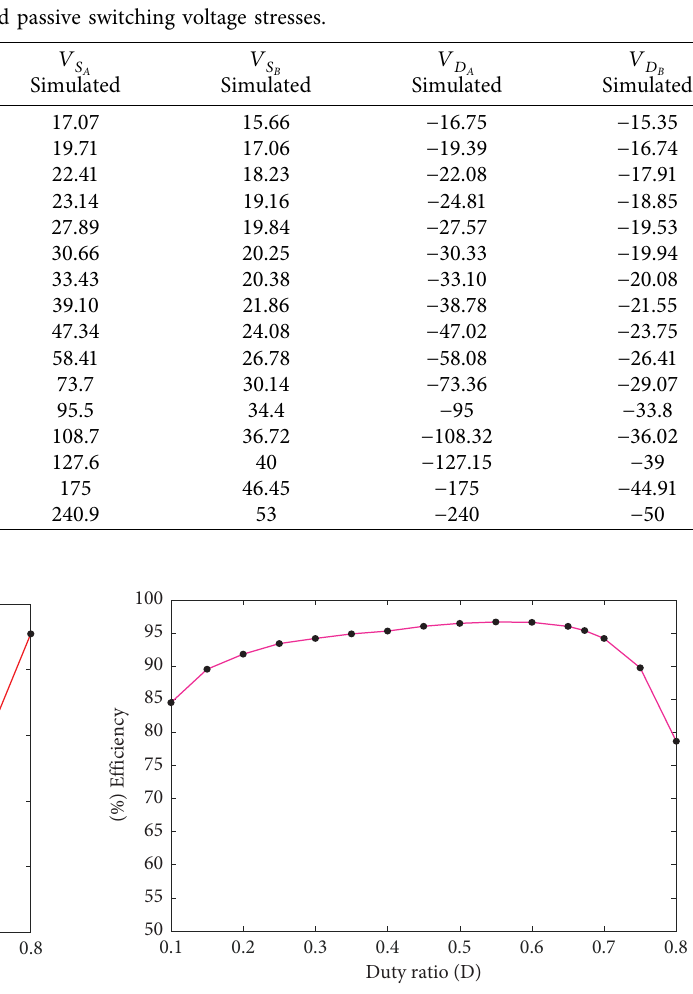
Figure 22: Te designed converter’s efciency curve in terms of ) out duty ratio ( D